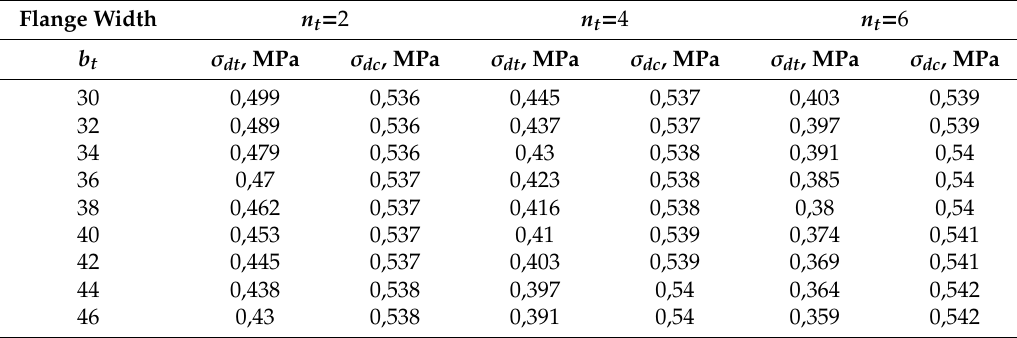
Figure 8. Dependence of dynamic normal stresses on the width of the I-beam flange b t and the number of reinforcement rods in the tension zone of a fiber-reinforced concrete beam, taking into account the mass of the beam and without taking into account the bimodularity at n c = 2, E c = 5000 MPa, E t = 5000 MPa: ( 1 ) dynamic tensile stresses at n t = 2; ( 2 ) dynamic compressive stress at n t = 2; ( 3 ) dynamic tensile stresses at n t = 4; ( 4 ) dynamic compressive stress at n t = 4; ( 5 ) dynamic tensile stresses at n t = 6; ( 6 ) dynamic compressive stresses at n t = 6. Table 7. Dependences of dynamic normal stresses on the width of the I-beam flange b t and the number of reinforcement bars in the tension zone of a fiber-reinforced concrete beam, taking into account the mass of the beam and without taking into account the bimodularity at n c =